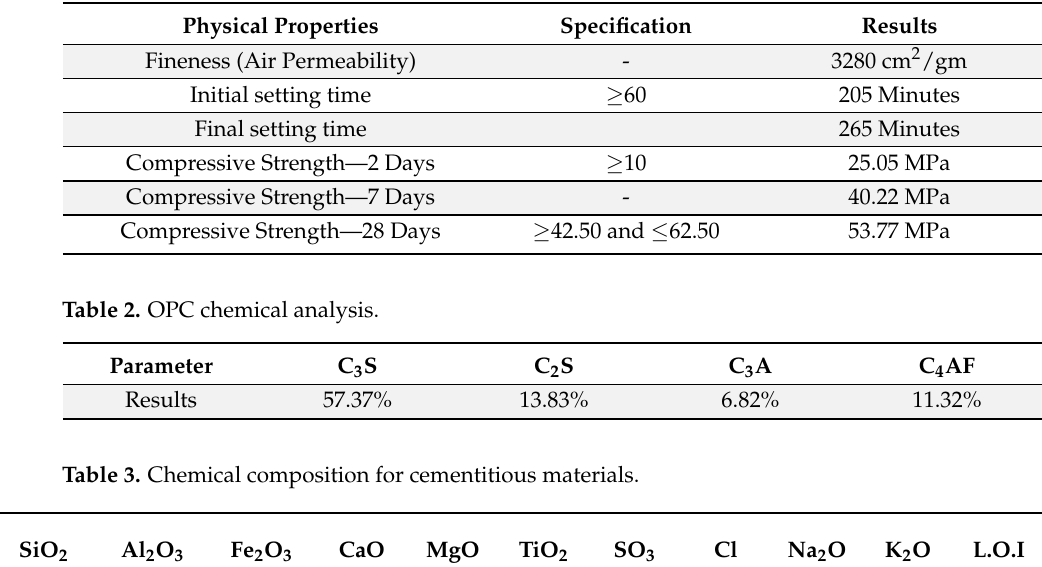
Table 1. OPC physical properties.